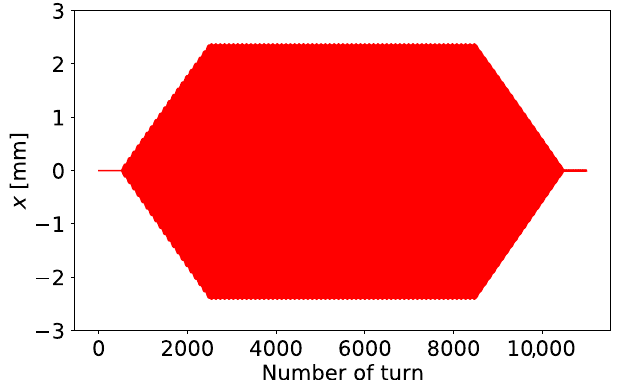
FIG. 7. Simulated excitation pattern of a driven oscillation of about 2 mm at a location with a horizontal β function of 180 m at a frequency ν d x of 0.299.